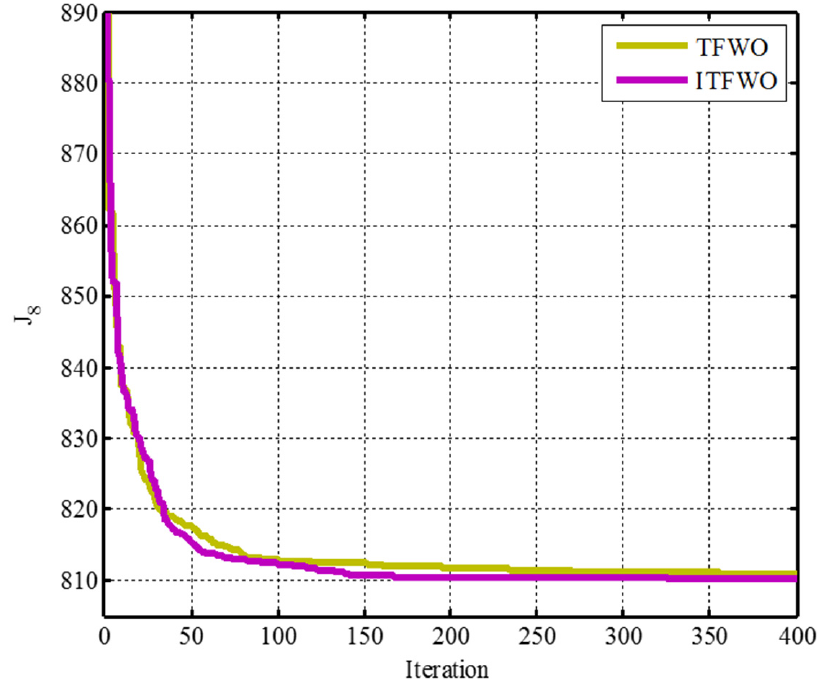
Figure 10. Optimization process for Type 8.